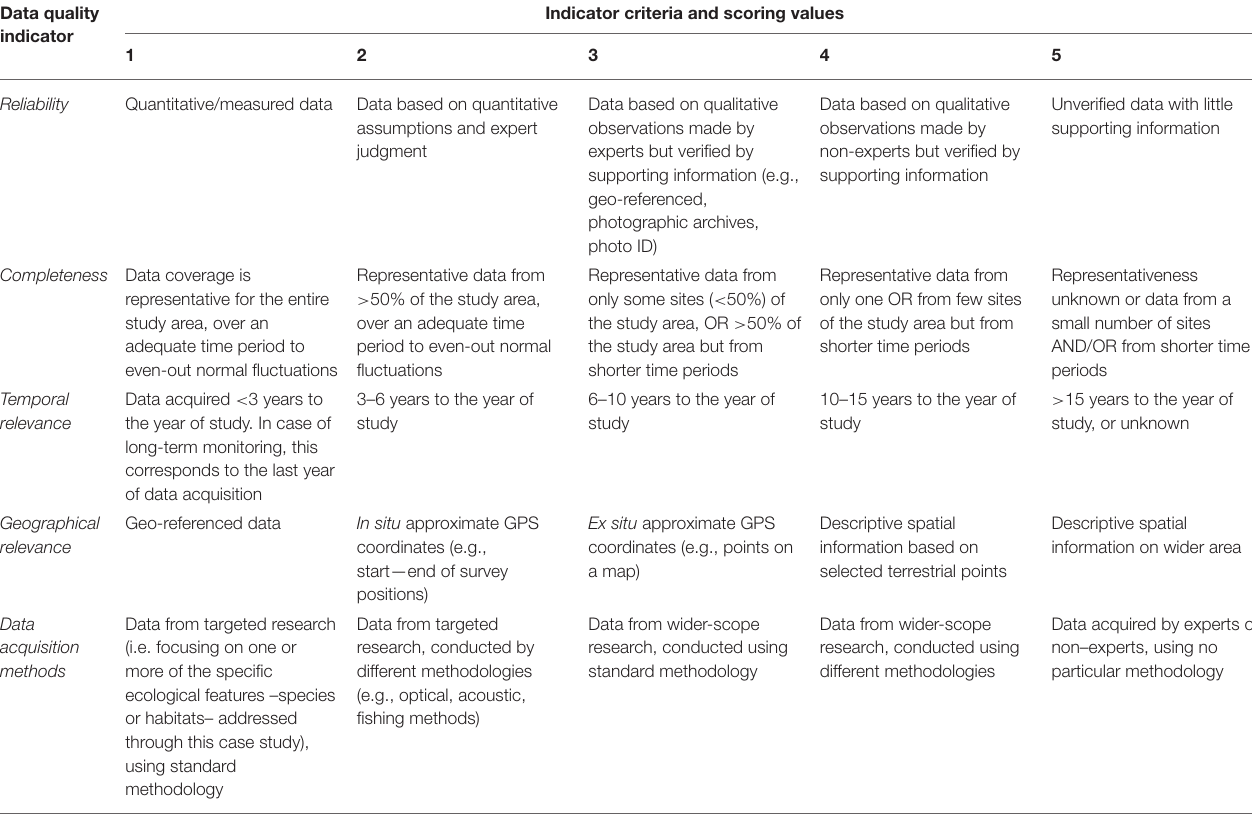
TABLE 3 | Data quality evaluation based on a pedigree matrix adapted from Weidema and Wesnæs (1996) and Issaris et al. (2012). Data quality